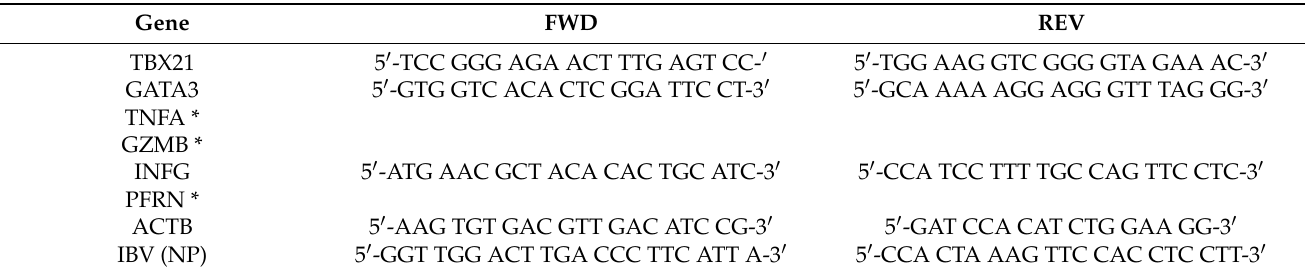
Table 1. Oligonucleotides used for gene expression